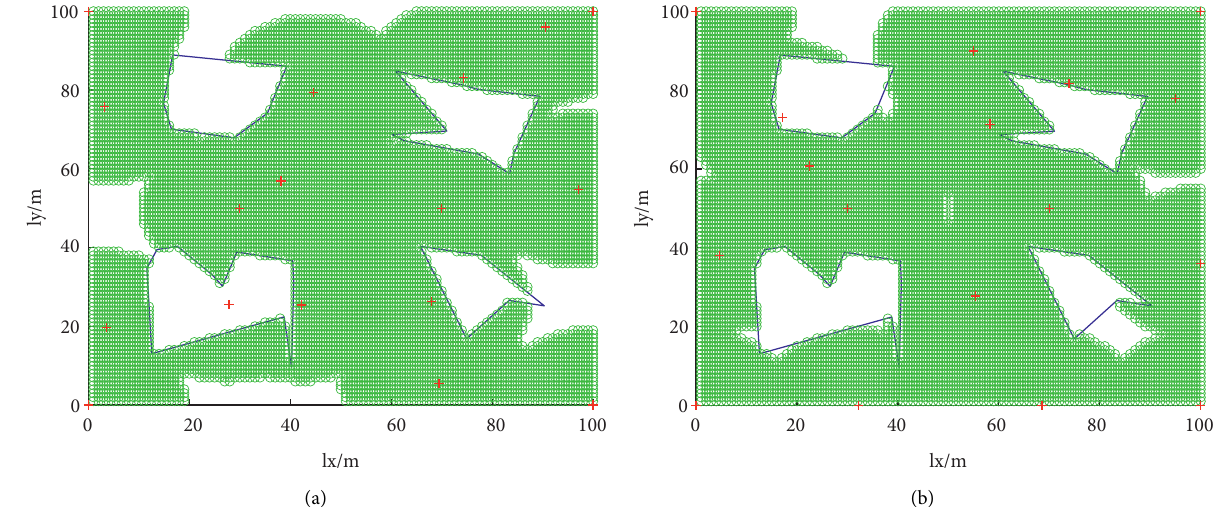
Figure 13: Network coverage of 11 nodes: (a) before optimization and (b) after optimization.